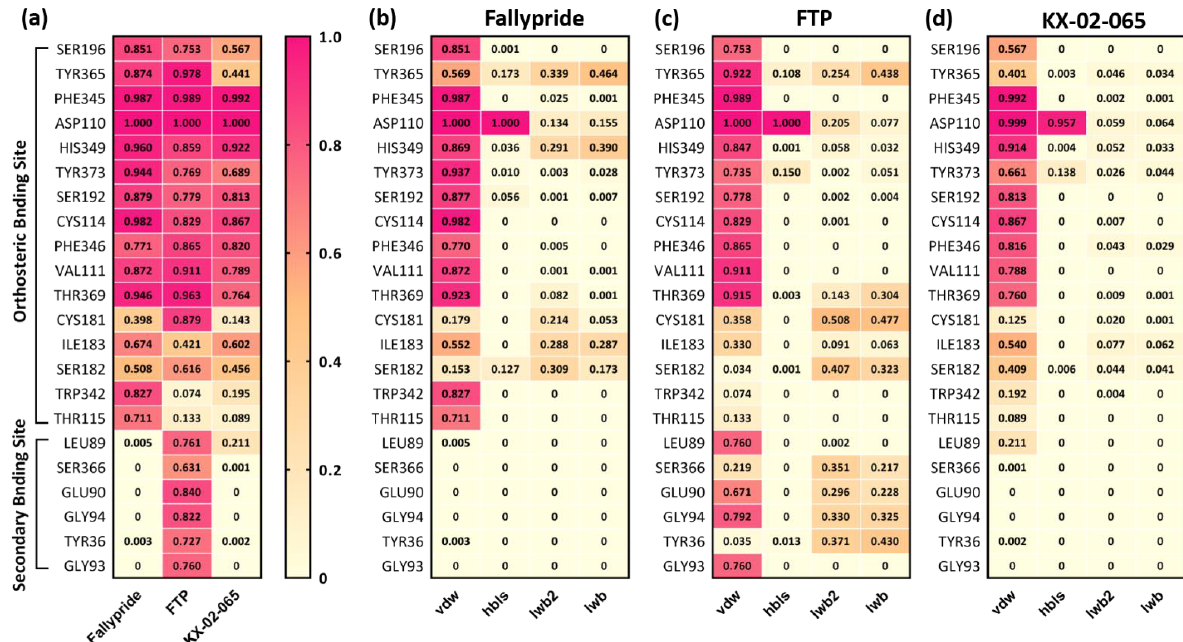
Figure 4. ( a ) The summation of all types of the frequency of contacts between the residues in the binding pocket and Fallypride, FTP, and KX-02-065. The frequency of van der Waals (vdW), ligand-sidechain hydrogen bonds (hbls), ligand water-mediated hydrogen bond (lwb), and ligand extended water-mediated hydrogen bond (lwb2) interactions between sidechains and ( b ) Fallypride, ( c ) FTP, and ( d ) KX-02-065. The summation of all types of the frequency of contacts between any residue and any ligand higher than 0.6 is shown in the